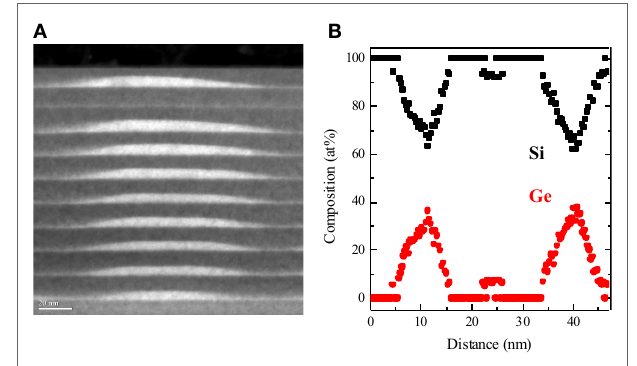
FiGURe 14 | (A) A cross-sectional transmission electron micrograph (TEM) image showing the Si/SiGe NL/CM nanostructure with the very thin SiGe NL fourth from the top (Si) layer, and (B) energy-dispersive X-ray (EDX) measured composition of the sample’s six topmost layers. The arrow shows the direction of the EDX scan. The scale bar in the TEM image is 20 nm in length (Mala et al., 2014).